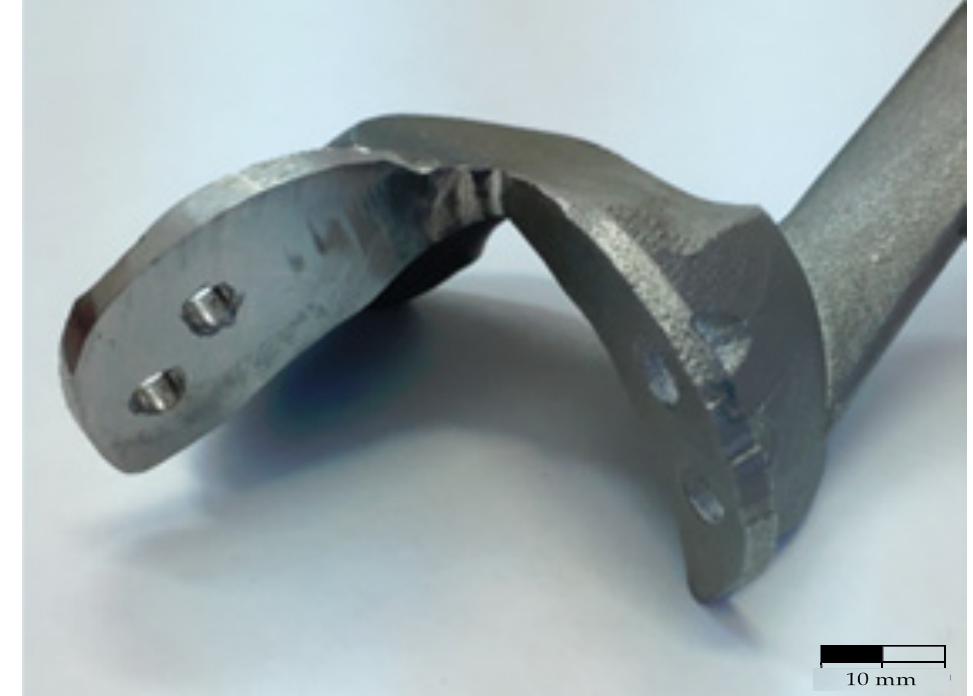
Figure 9. Custom implant resulting from the cutting machining.